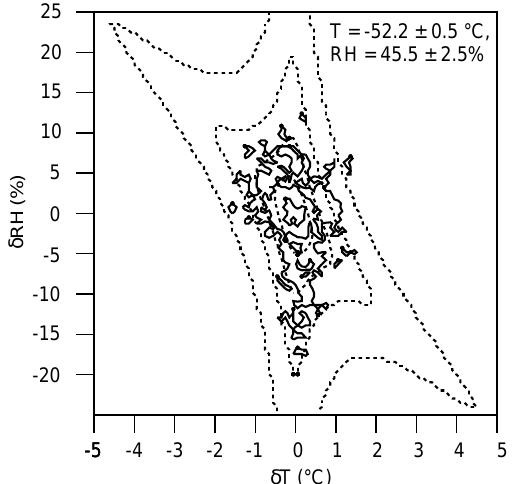
Fig. 8. Direct comparison of a (non-normalized) empirical jpd ( solid ) with a corresponding theoretical jpd ( dashed ) for a constrained data base. The fluctuation data in the empirical jpd refer to mean values in the small intervals indicated along the top border of the Fig., the theoretical jpd is drawn for the central state in this interval. The empirical jpd is rather noisy, because the data base is small. Contour values are 1, 3 and 10 events for the empirical jpd, and 0.001, 0.003, 0.01, and 0.03 for the theoretical jpd. The empirical jpd has not been normalised because the statistical errors are large and a normalisation would pretend only small statistical errors